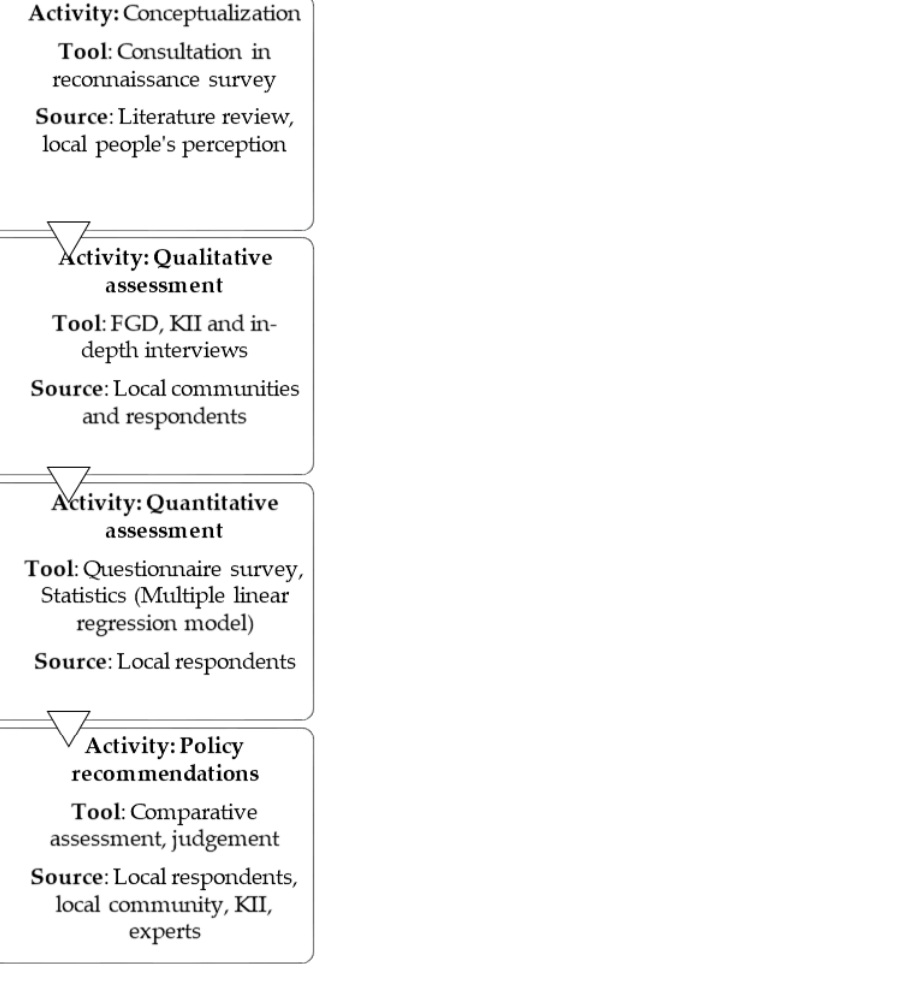
Figure 3. Evaluation framework for gender-differentiated impacts of water poverty in Singair Upazila (Adapted from